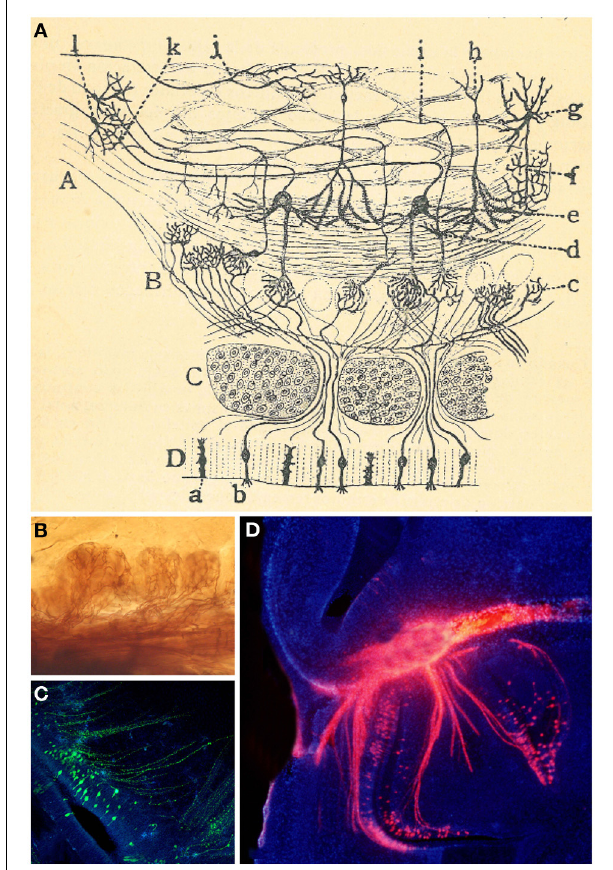
FIGURE 4 | Connection between the olfactory epithelium and the olfactory bulb. (A) Cajal schematic drawing of the mammal’s olfactory system. (A) Olfactory lobe. (B) Olfactory bulb’s glomerular layer. (C) Cribriform plate. (D) Olfactory epithelium or nasal mucosa; (a) supporting cells; (b) OSNs (Ramón y Cajal, 1892b). (B) Axonal arborizations of OSNs axons in several glomeruli stained with the Golgi method. (C) Olfactory sensory neurons (green) at E17, labeled after in utero electroporation of an EGP-expressing plasmid into the olfactory placode at E11. Nuclei counterstained with Hoechst (blue). Sagittal mouse section. (D) Retrogradely labeled OSN cells after a DiI crystal application into the OB (red). Hoechst (blue).